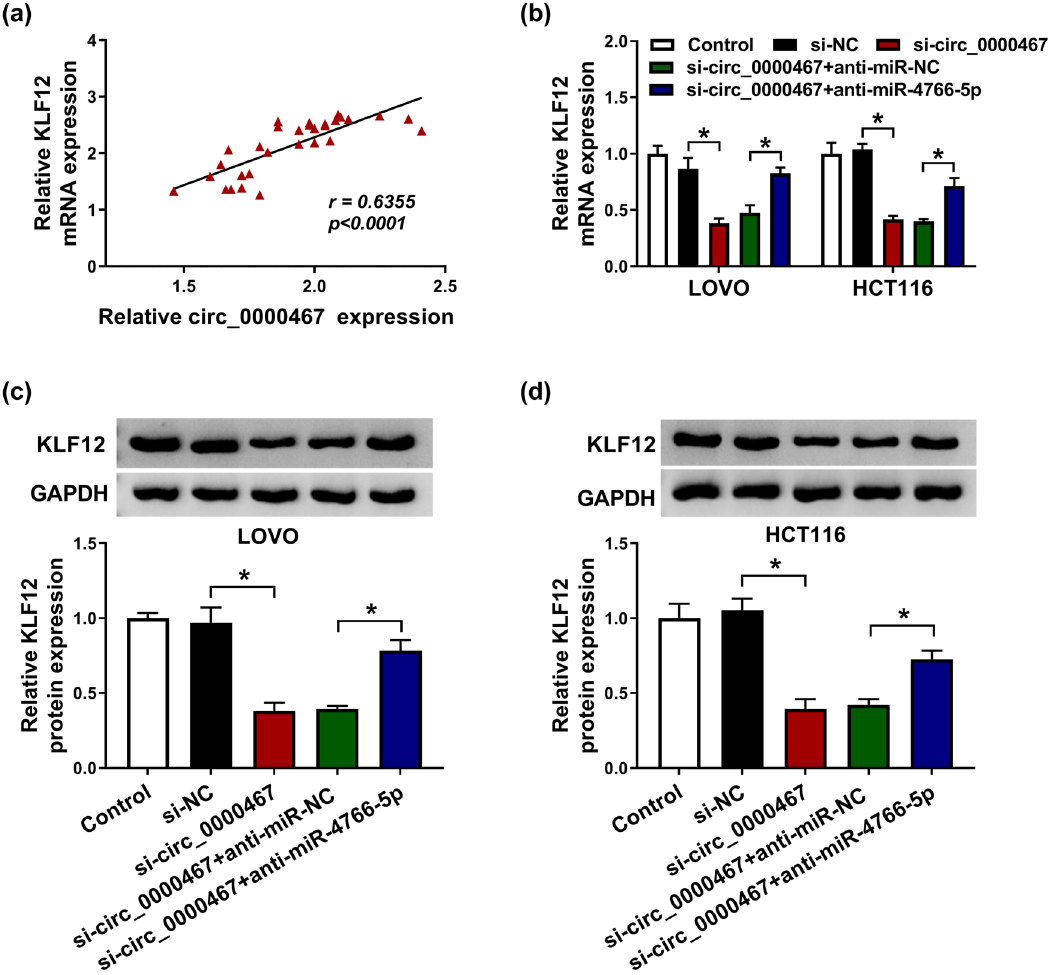
Figure 7: Silencing circ_0000467 repressed KLF12 expression via upregulating miR - 4766 - 5p. ( a ) Pearson ’ s correlation coe ffi cient was used for analyzing the relationship between circ_0000467 and KLF12 in CRC tissues. ( b ) The KLF12 mRNA level was examined by RT - qPCR in LOVO and HCT116 cells transfected with si - circ_0000467, si - circ_0000467 + anti - miR - 4766 - 5p, or the relevant controls. ( c and d ) KLF12 protein expression was detected by WB in transfected LOVO and HCT116 cells. * P <